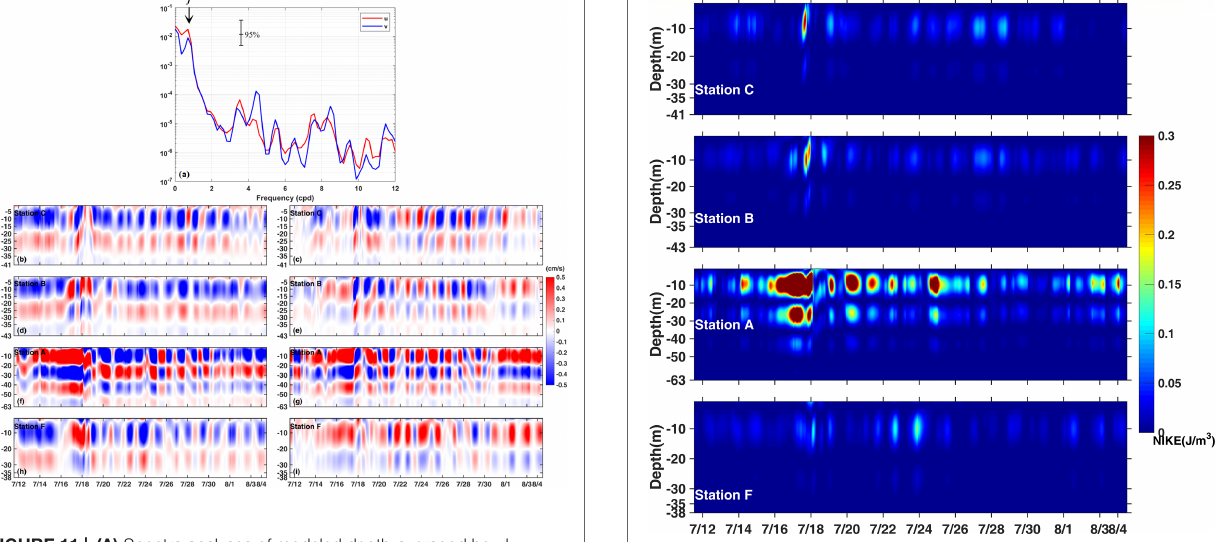
FIGURE 12 | Time series of vertical profiles of near-inertial kinetic energy (J/m 3 ) at stations (C, B, A, F)